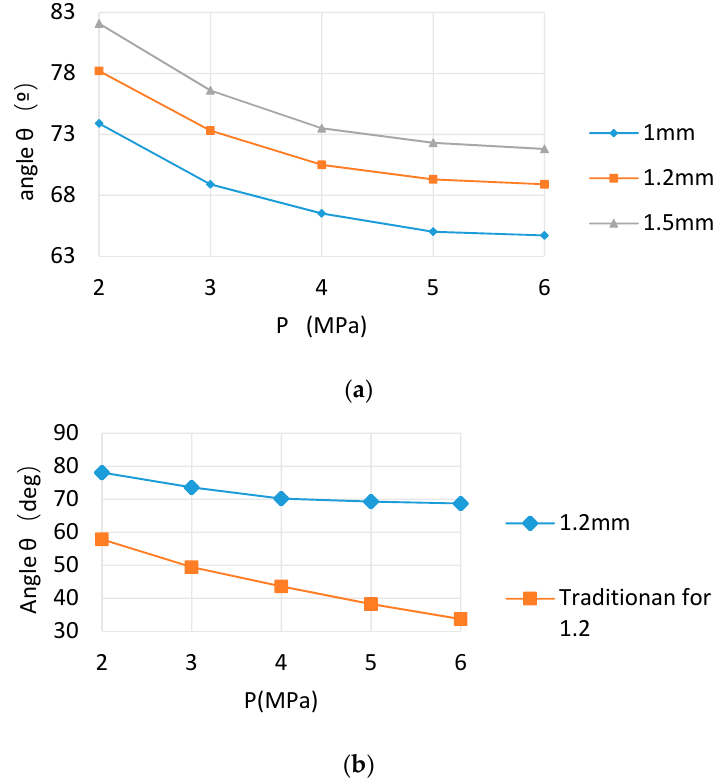
Figure 7. Atomization angle in different spray pressures. ( a ) Atomization angles and spray pressures for three nozzle apertures. ( b ) The comparison between the nozzle and the traditional nozzles in the spray angle.